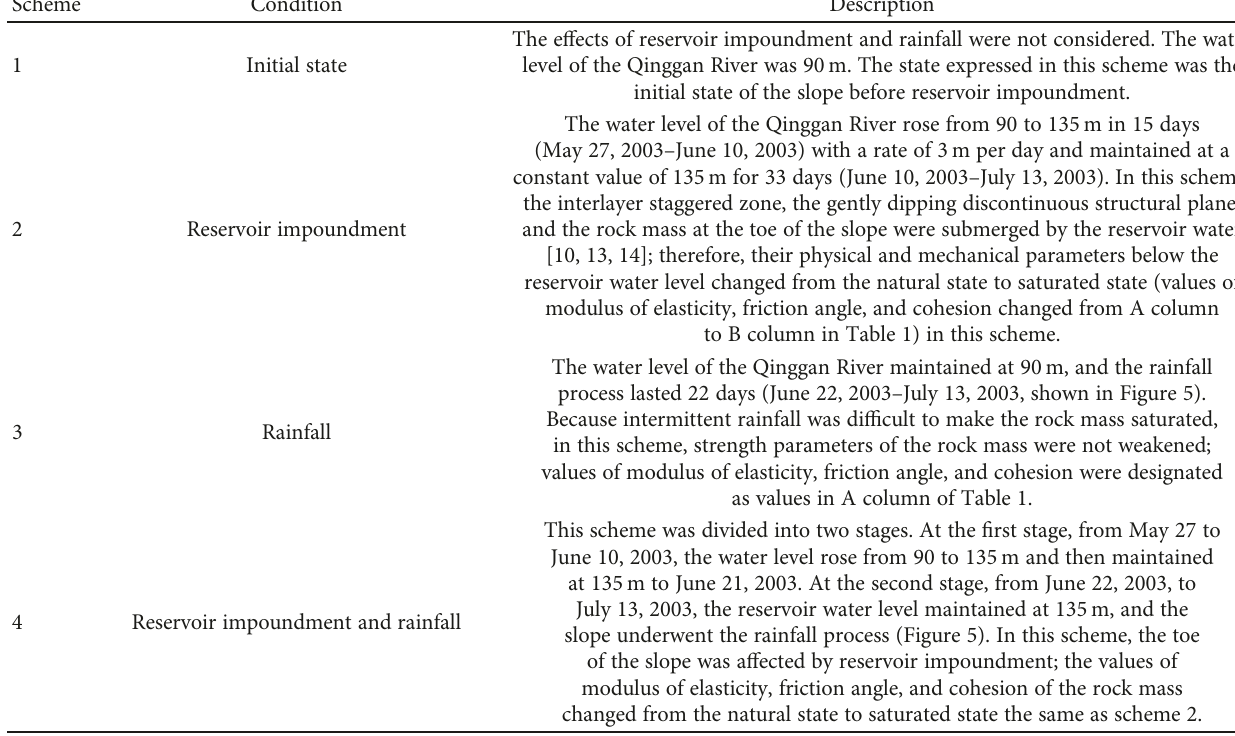
Table 2: Schemes for numerical